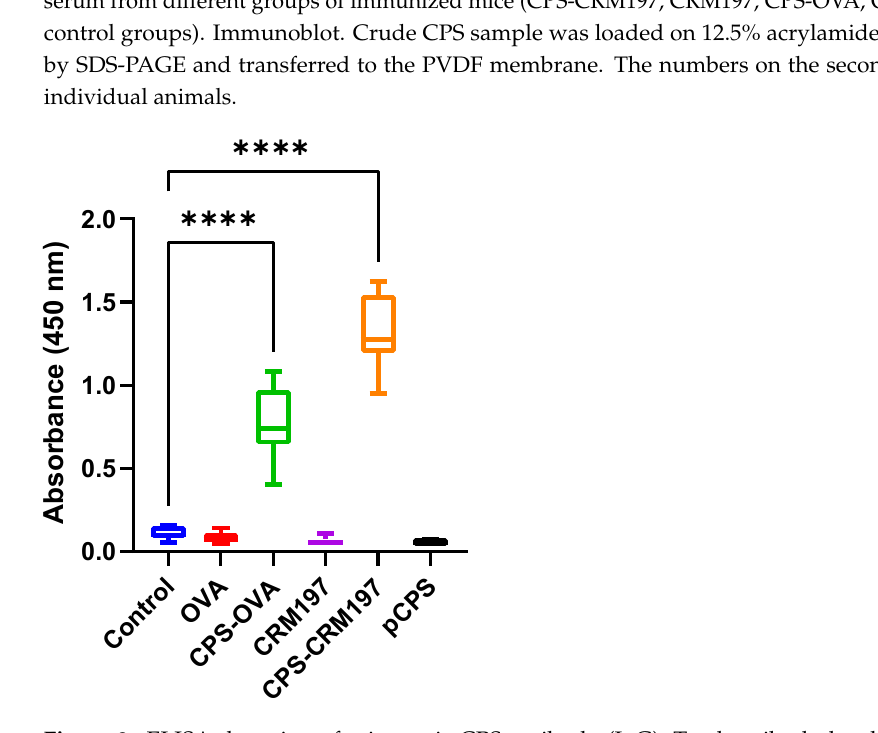
Figure 3. ELISA detection of mice anti-cCPS antibody (IgG). Total antibody levels against cCPS in mouse serum two weeks after the second vaccine dose. ELISA plates were coated with S. suis serotype 2 capsular polysaccharide and incubated with mice serum (dilution 1:100). Total levels of IgG were measured for all six groups (n = 10 each) at 450 nm. Both mice groups immunized with conjugates developed high antibody response, significantly higher (****, p ≤ 0.0001) than the control (not vaccinated), OVA, CRM197 or pCPS